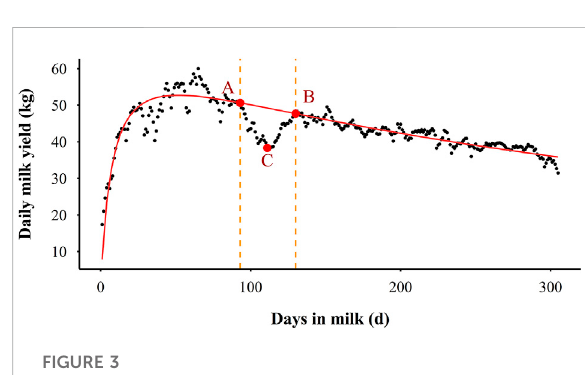
FIGURE 3 Anillustrativeexampleofthede fi nitionofthemilk fl uctuation phase. The scatter indicates the actual daily milk yield, the red line represents the expected lactation curve (ELC), the section AB is a fl uctuation phase, point A is the start of the fl uctuation, point B is the end of the fl uctuation, and point C is the highest decrease of the fl